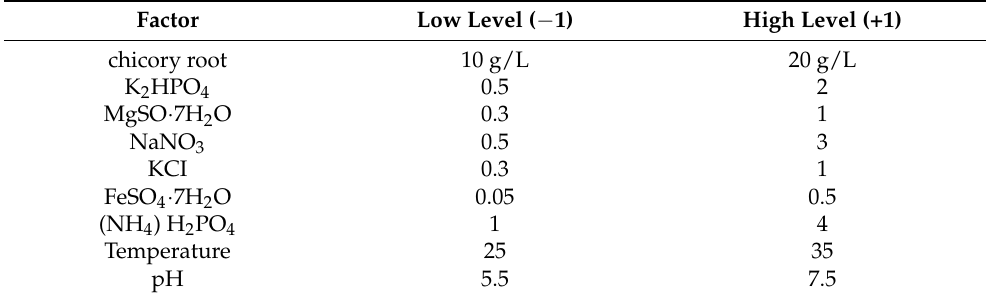
Table 1. Variables and their levels employed in the Plackett–Burman design for screening of variables affecting inulinase production by Rhizopus oryzae NRRL 3563. Factor Low Level ( − 1) High Level (+1) chicory